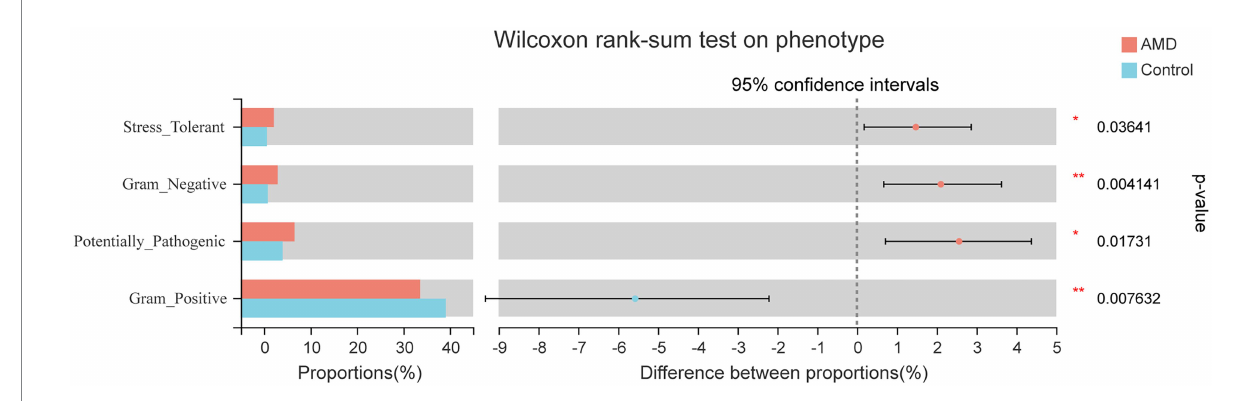
FIGURE 5 Phenotypic prediction difference test between AMD patients and controls.